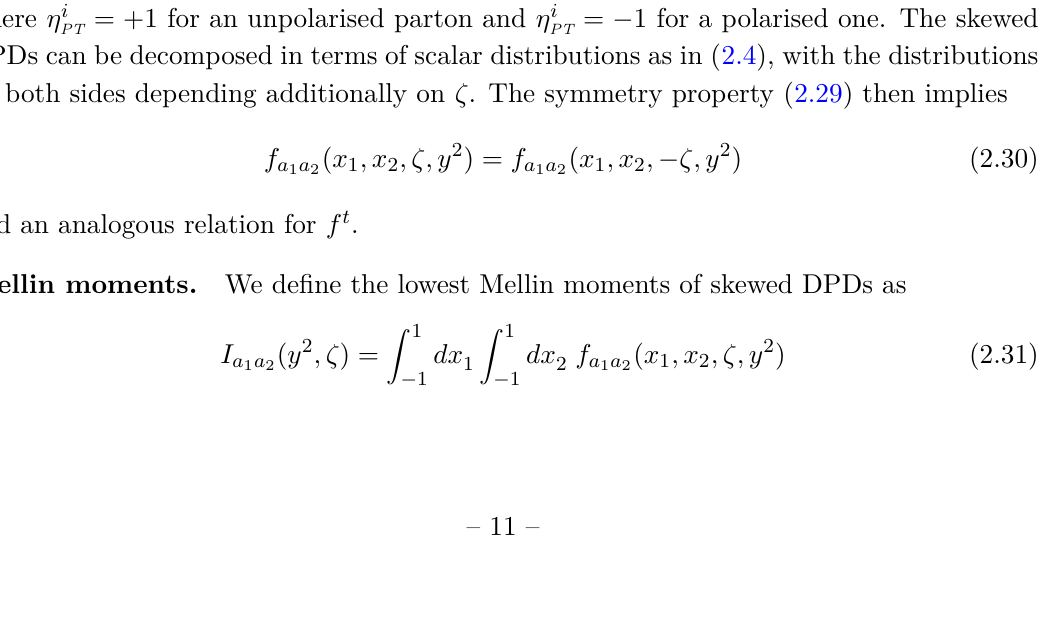
Figure 2 . Support region of the distribution F ud ( x 1 , x 2 , ζ, y ) in the momentum fraction arguments. The notation d | du ¯ u means that one has one d quark in the wave function of | h i and du ¯ u in the wave function of h h | . In both panels, the triangle for the region ud | du has the corners (cid:0) 1 (cid:1) (cid:0) (cid:1) | ζ | , 1 − 1 | ζ | and 1 − 1 | ζ | , 1 | ζ | . Notice that the parton configuration in each of the four triangles 2 2 2 2 is the same for positive and negative ζ , whereas the configuration in each of the squares is